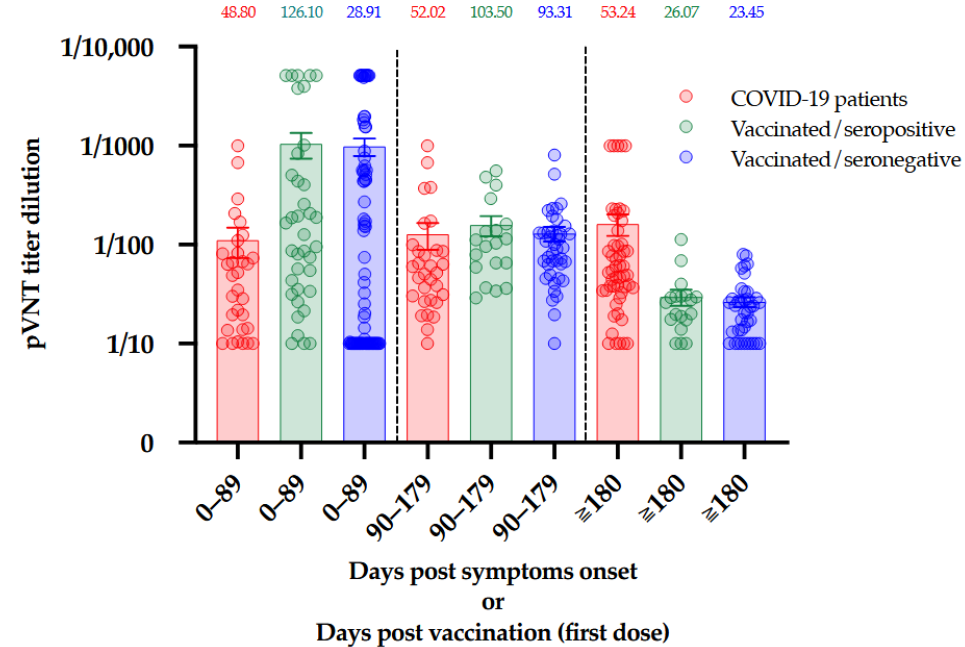
Figure 4. Comparison of NAbs titers between COVID-19 patients, seropositive vaccinated individuals, and seronegative vaccinated individuals at three different timeframes. The median is presented on top of each timeframe for each population. Bars represent the mean and standard error or mean.